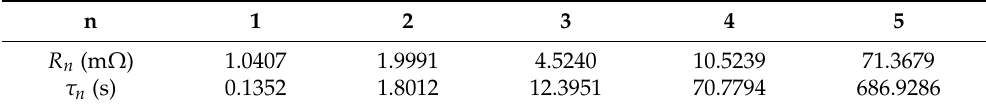
Table 1. Values of the parameters for the RC elements.